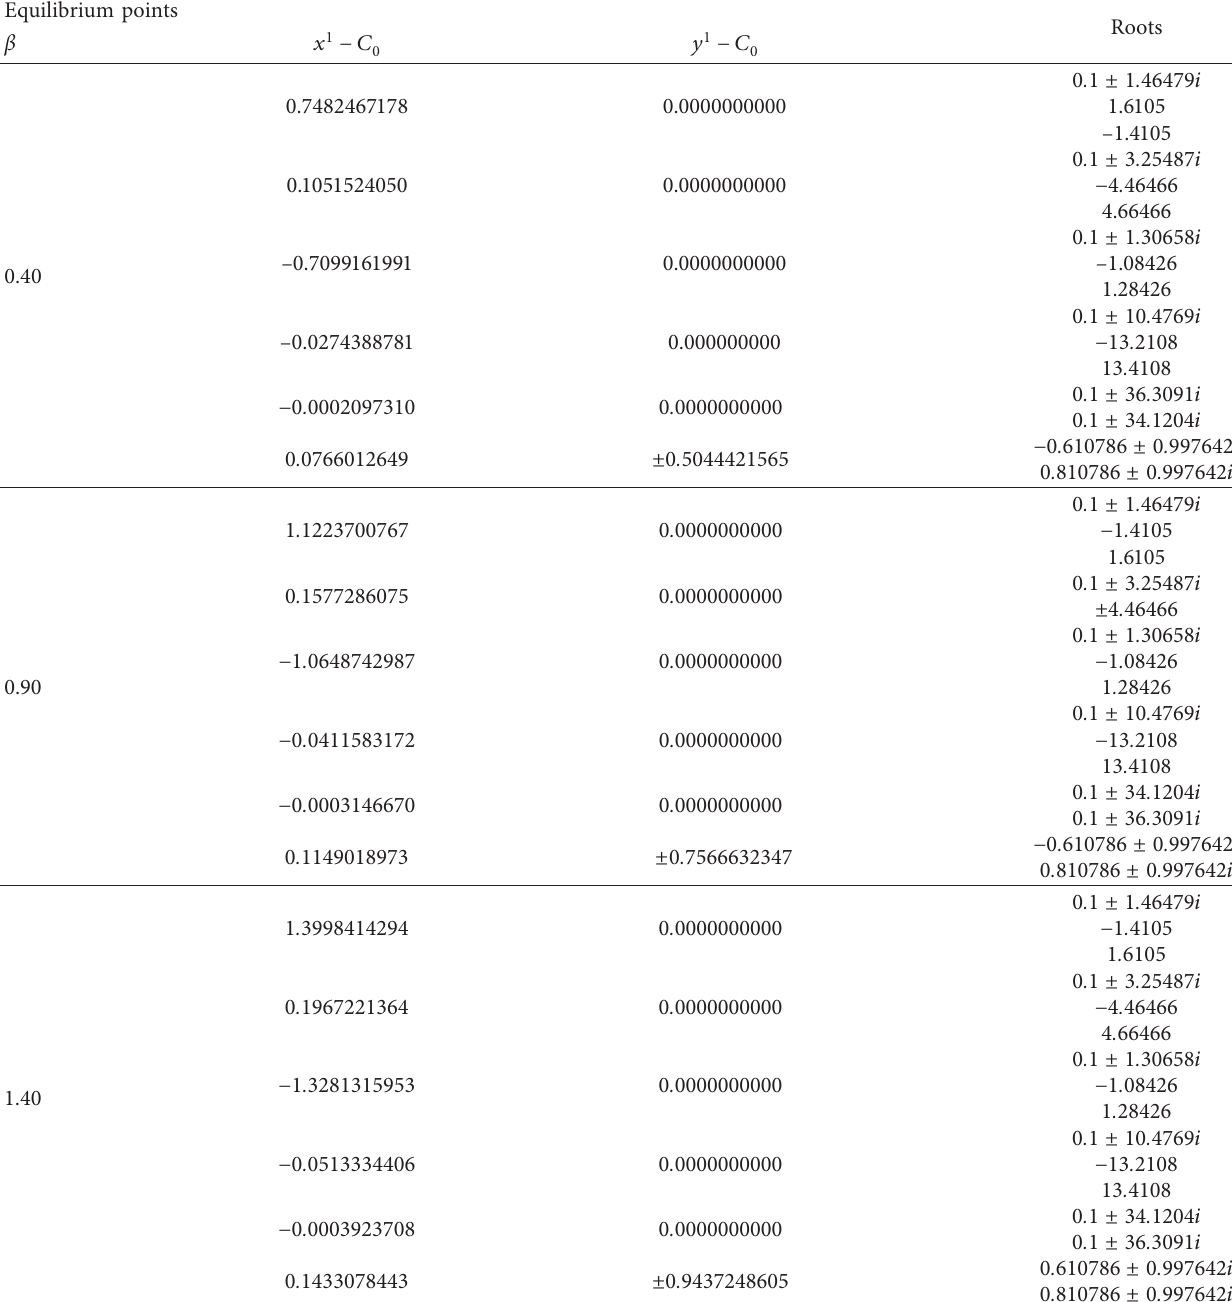
Table 1: All the equilibrium points depicted are unstable and determined for T � 0 . 02, q M � 0 . 01, μ � 0 . 4, and α � 0 . b